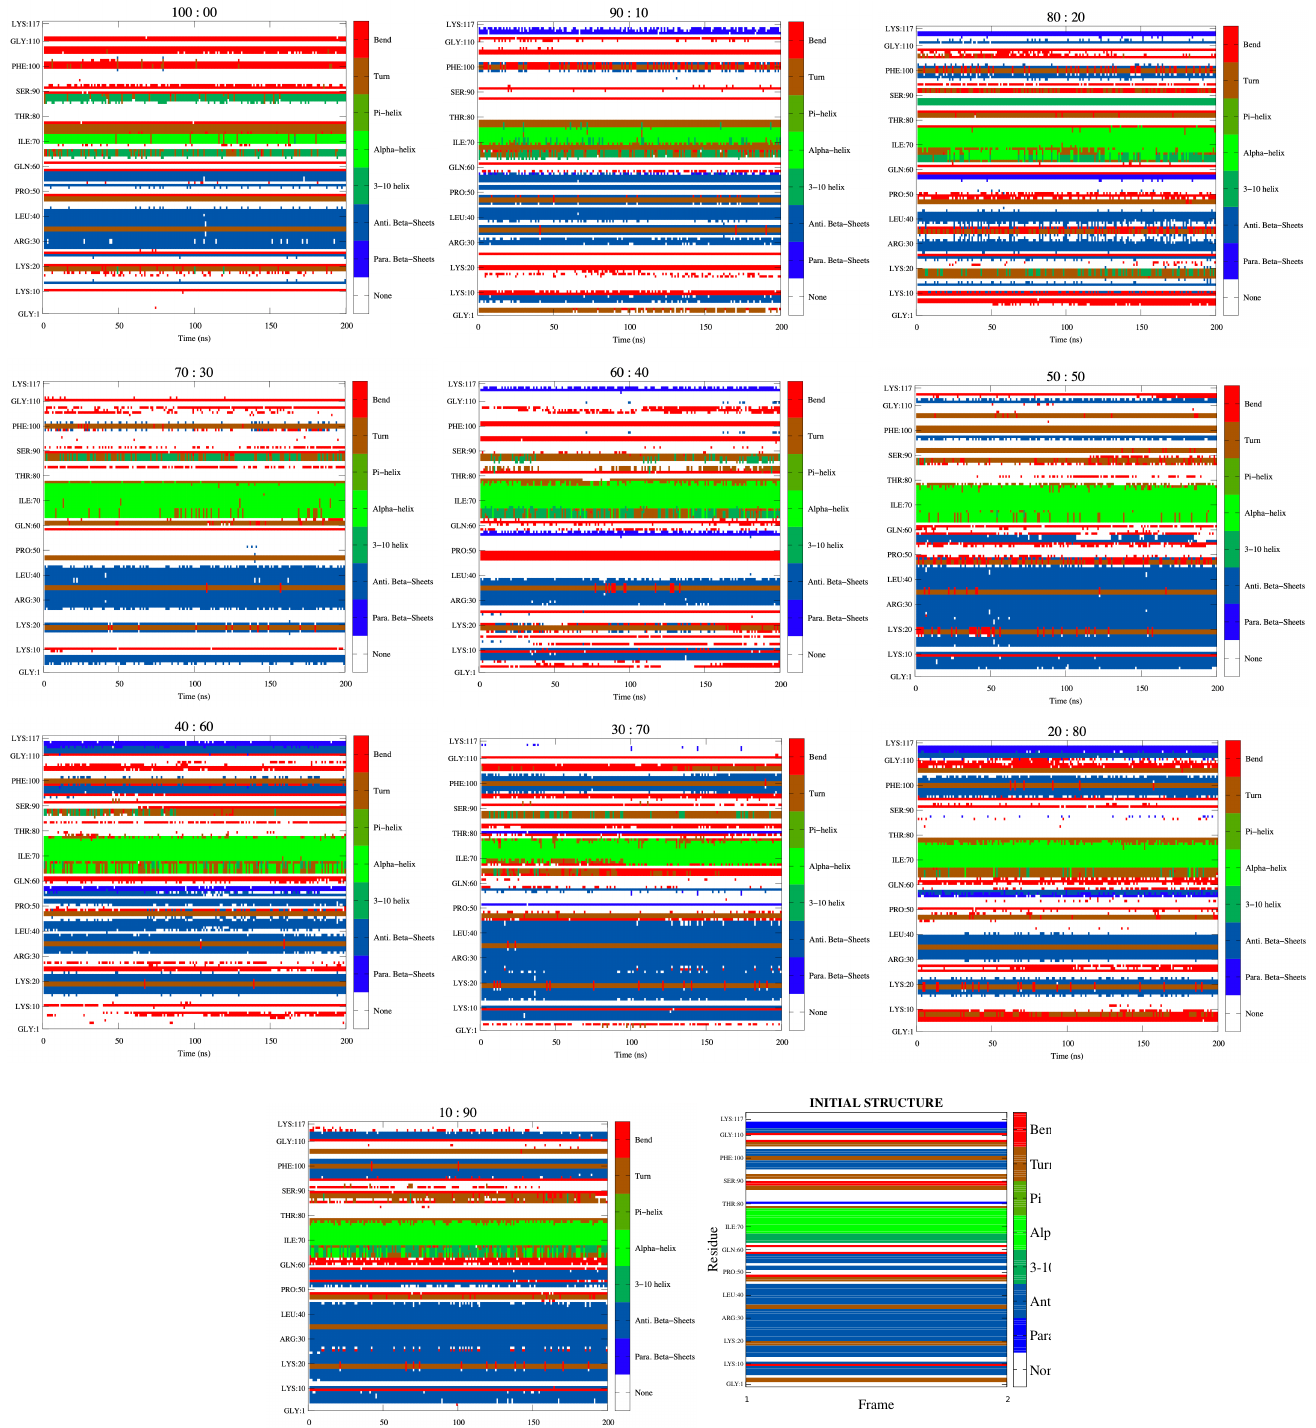
Figure 5. Secondary structure analysis (via the Kabsch and Sander procedure [42]) of the RVFV L protein domain at 298.15K in the pure glycerol, and aqueous glycerol